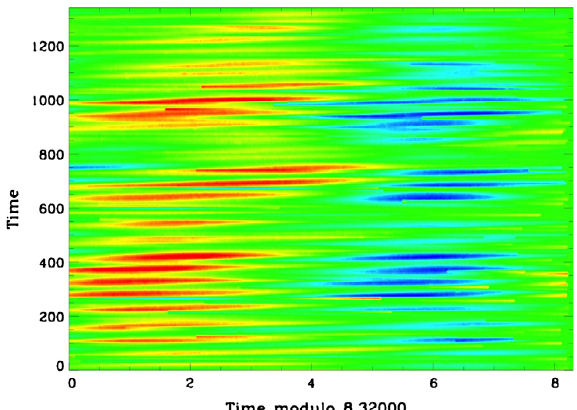
Fig. 5. Phase diagram as described in Section 4 with the time modulo a value close to the rotation period of the star on the x -axis and the time on the y